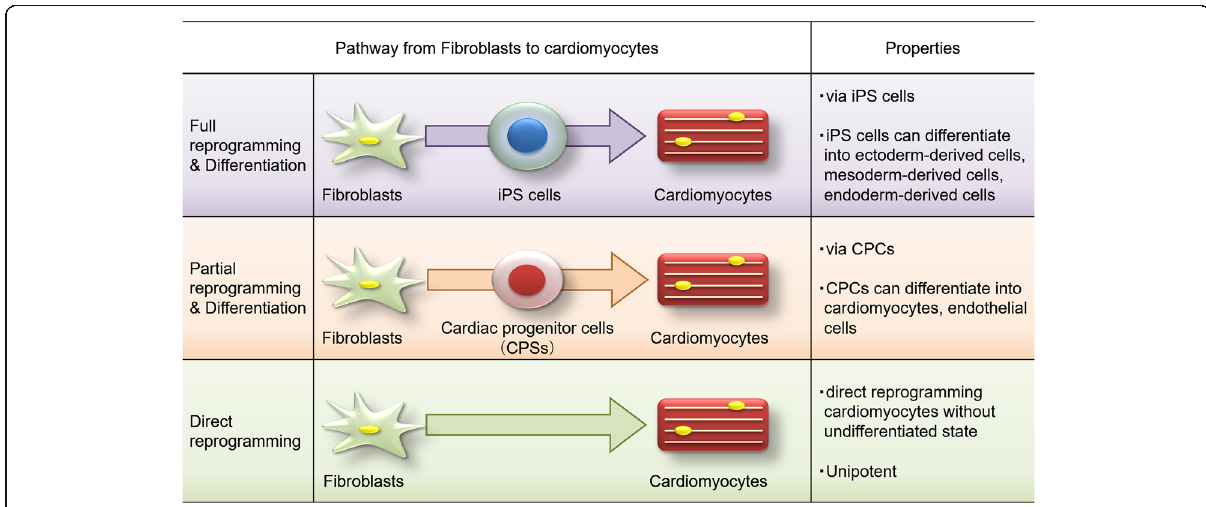
Fig. 1 Three pathways for deriving cardiomyocytes for myocardial regeneration [4]. There are (1) full reprogramming approaches (purple line), (2) partial reprogramming approaches (orange line), and (3) direct reprogramming approaches (green line). For the treatment of myocardial infarction and heart failure, (1) iPS-derived cardiomyocytes are about to be clinically studied for myocardial transplantation experiments. (3) Direct cardiac reprogramming does not require cardiomyocyte transplantation and may be feasible through a direct reprogramming approach. (2) Partial reprogramming may offer the advantages of (1) and (3). Further research is desirable in the